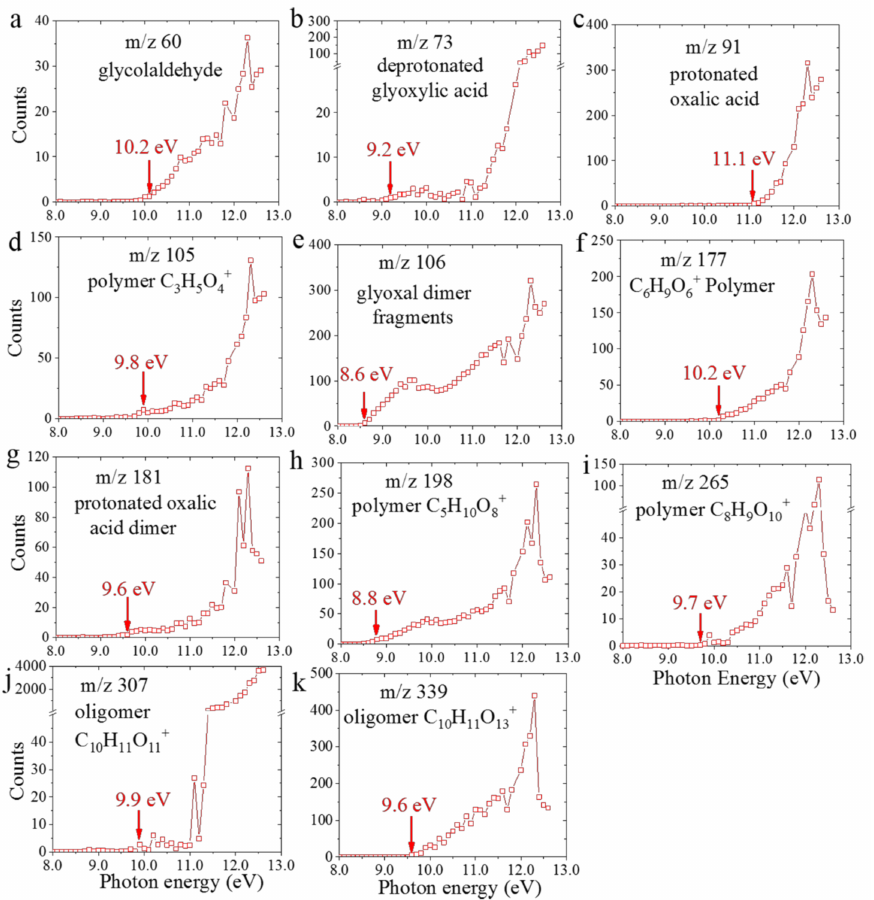
Figure 3. Photoionization efficiency curves of key products with appearance energies shown by arrows ( a ) glycolaldehyde ( b ), deprotonated glyoxylic acid, ( c ) protonated oxalic acid, ( d ) poly- mer, C 3 H 5 O 4+ , ( e ) glyoxal dimer fragments, ( f ) polymer C 6 H 9 O 6+ , ( g ) protonated oxalic acid dimer, ( h ) oligomer, C 5 H 10 O 8+ ( i ) oligomer, C 8 H 9 O 10+ , ( j ) oligomer, C 10 H 11 O 11+ , and ( k ) oligomer, C 10 H 11 O 13+ from the 2 h dark aging VUV SPI-MS